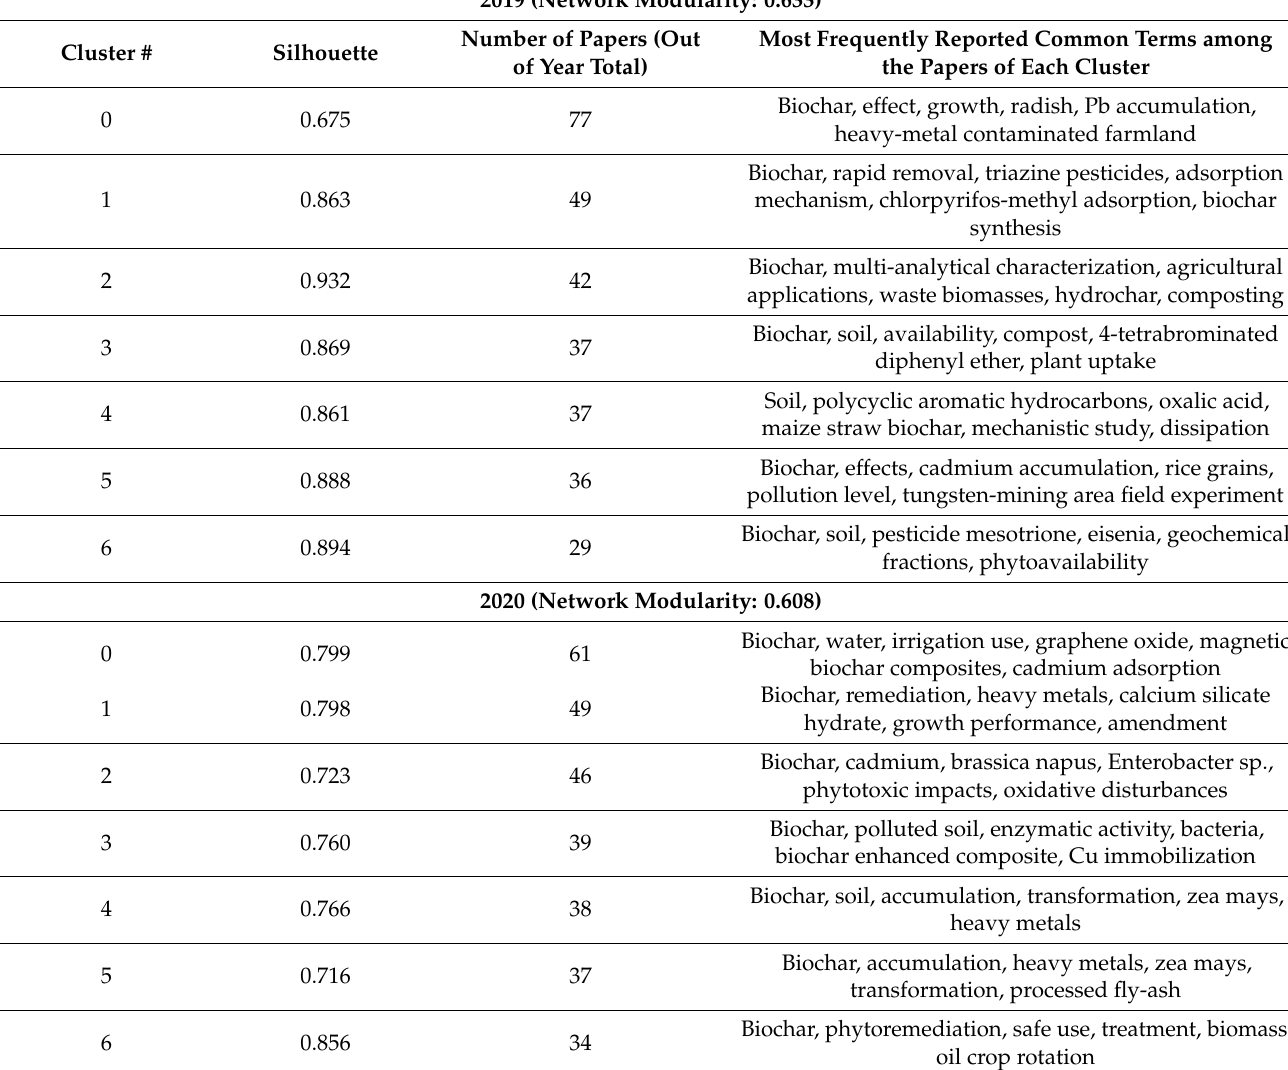
Table 2. Network modularity, cluster silhouette, the number of papers and the most frequently reported terms in the top 6 clusters in 2019 and